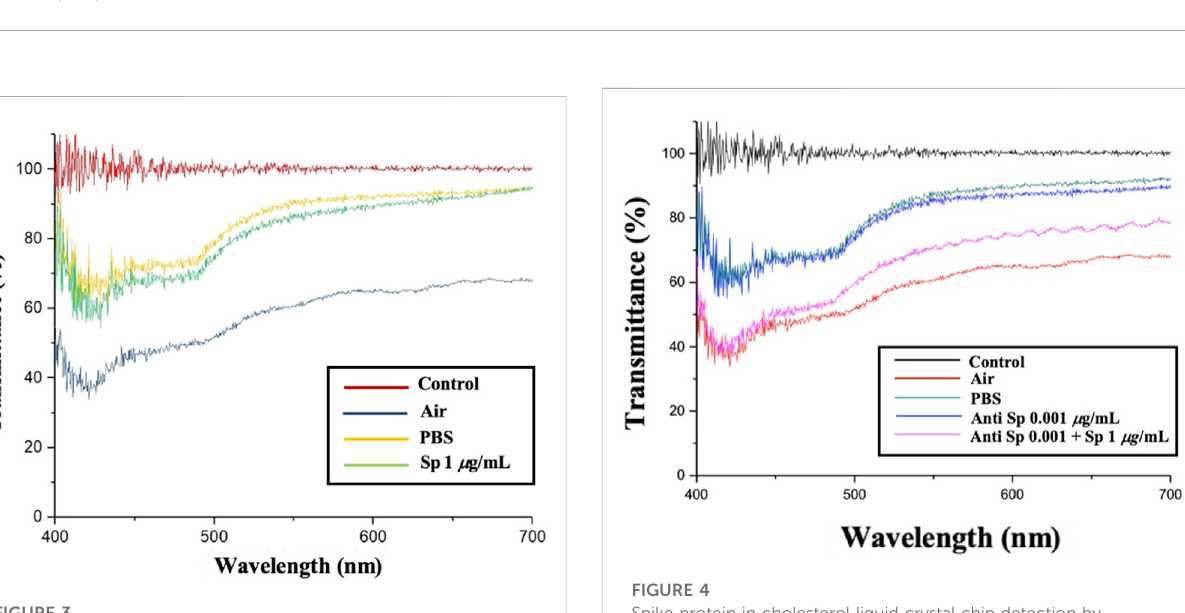
FIGURE 2 Optical images were taken by an orthogonal polarizing microscope under different environments of cholesteric liquid crystals. (A) Air environment, (B) PBSsolution, (C) 0.001 μ g/mLanti-spikeprotein(RBD), (D) 1 μ g/mLspikeprotein(RBD),and (E) 0.001 μ g/mLanti-spikeprotein(RBD)+1 μ g/mLspike protein